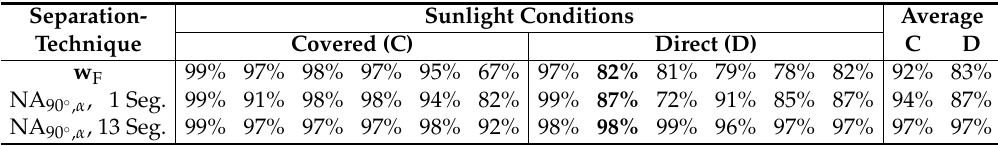
Table 3. We recorded a total of 12 panoramic images and divided them into two groups; one group where direct sunlight is shining onto the sensor (e.g., Figures 15 and 16) and one where the Sun is covered by clouds. The classification rates for the separation techniques tested on each panoramic image, as well as the average classification rate for each group is shown; the column representing the results for the skyline shown in Figure 17 is highlighted (bold).